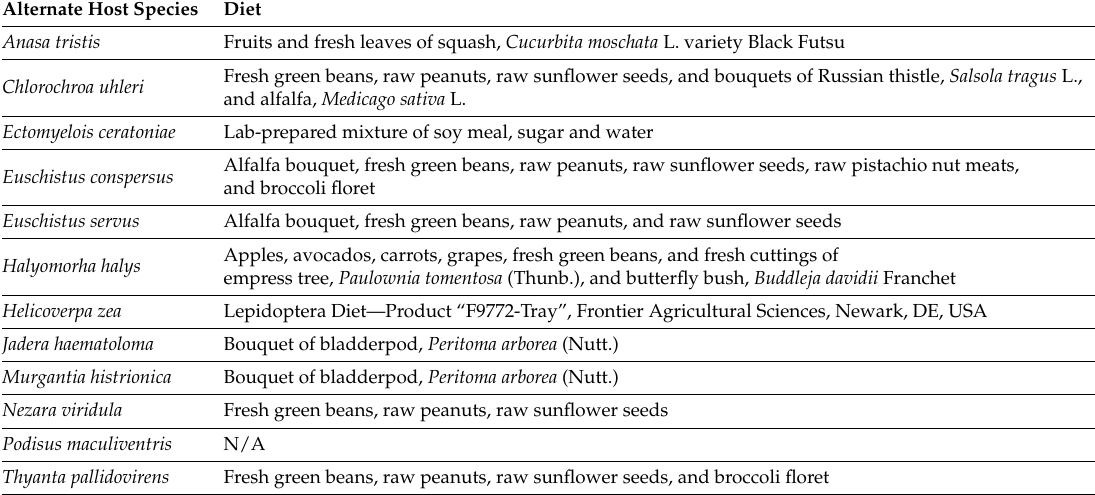
Table 1. Alternate host